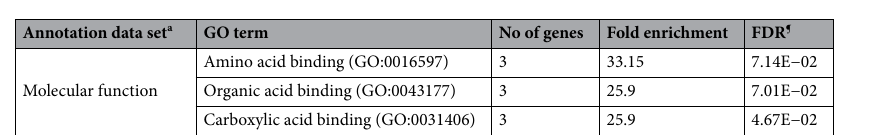
Table 3. PANTHER gene ontology (GO) enrichment analysis of upregulated genes. Displaying only results for FDR p < 0.05. ¶ p-value from Fisher’s exact test with false discovery rate (FDR) correction for multiple testing. a PANTHER GO-Slim